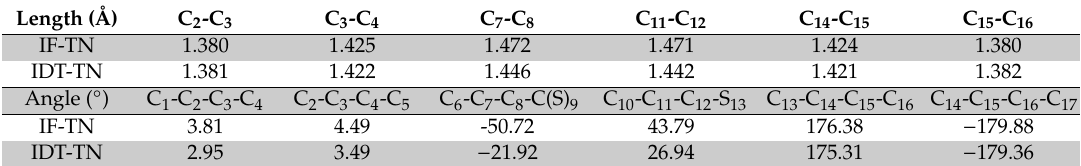
Table 1. The bond lengths and bond angles for non-fullerene acceptor-based IF-TN and IDT-TN. Length